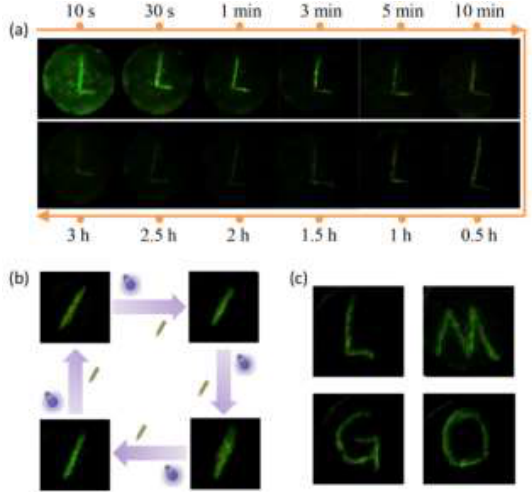
Figure 3. Optical photographs of ML induced by handwriting in diverse conditions. ( a ) Visualization of ML generated by handwriting letter “L” at di ff erent delay times (10 s–3 h). ( b ) Recoverable ML after UV irradiation. ( c ) ML generated by handwriting di ff erent letters on the same sample after UV